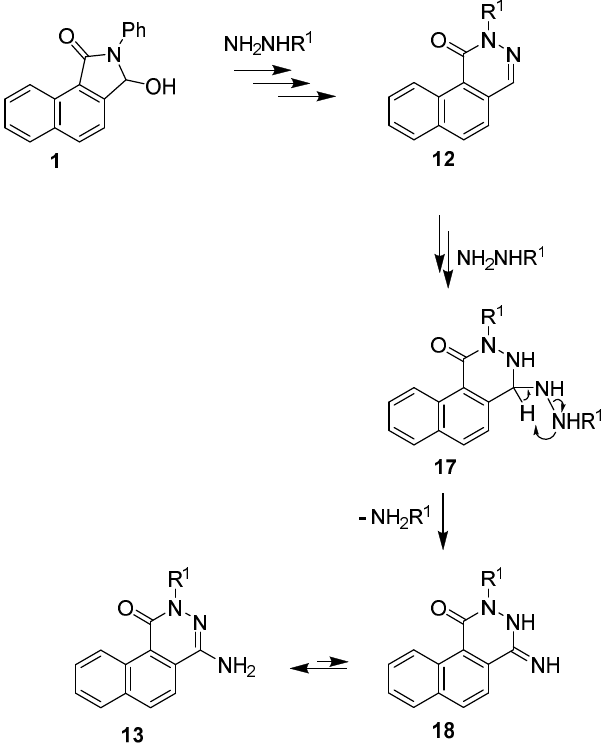
Scheme 5. Proposed method of formation of 4-aminophthalazinones 13